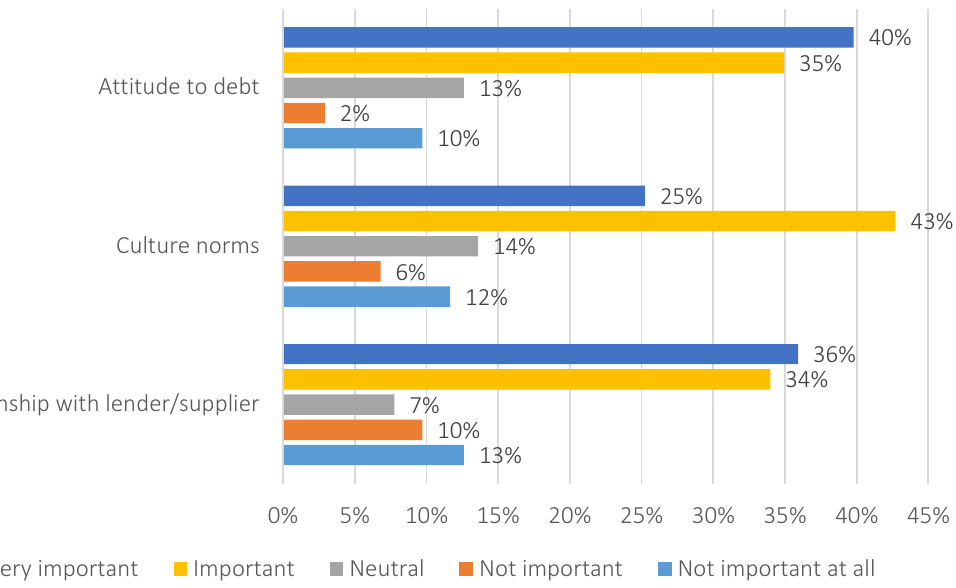
Figure 1. Factors affecting financial